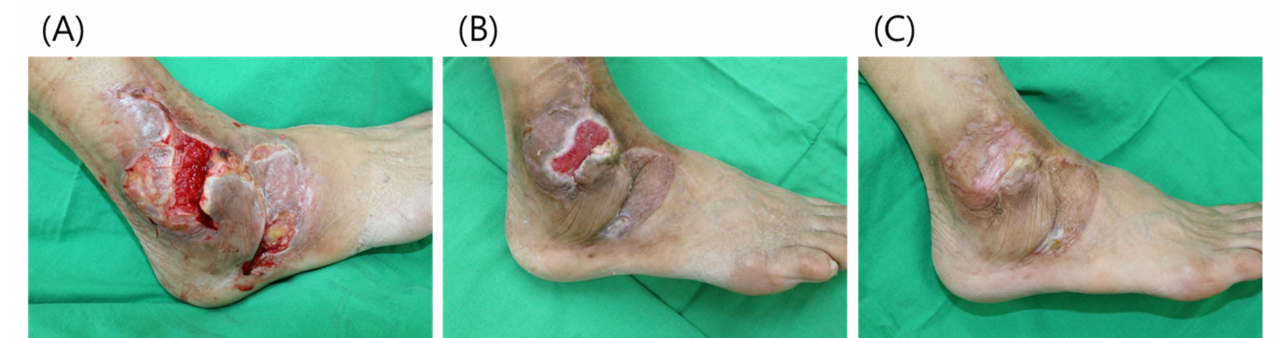
Figure 8. ( A ) A 65-year-old male patient presented with a diabetic foot ulcer. ( B ) After 4 weeks, the wound on the foot had healed almost completely and the wound at the lateral malleolus was covered with healthy granulation tissue. ( C ) At week 12, the wound had healed completely without discomfort in the foot or ankle; normal function also